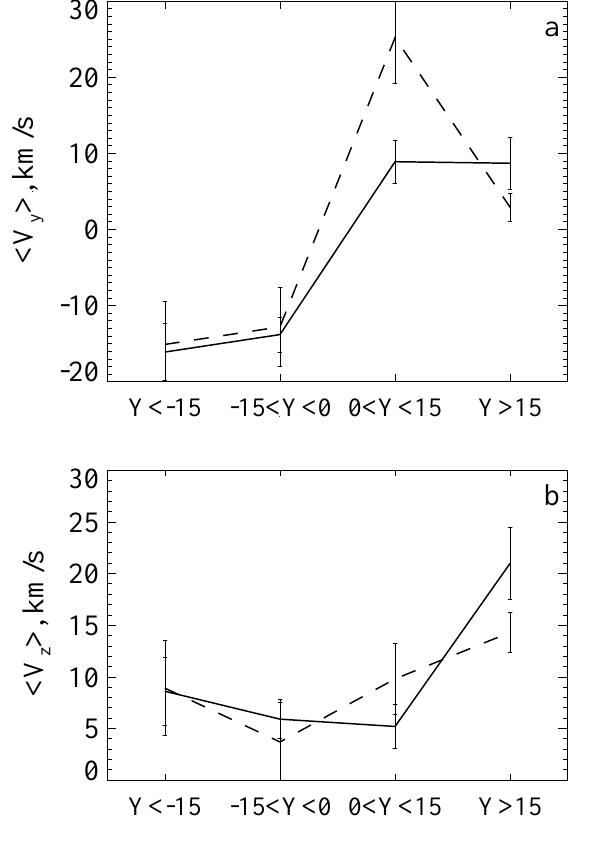
Fig. 5. Mean V y (a) and V z (b) velocities in the inner (dashed curves) and the outer (solid curves) plasma sheet with respect to the Y GSM spacecraft position.